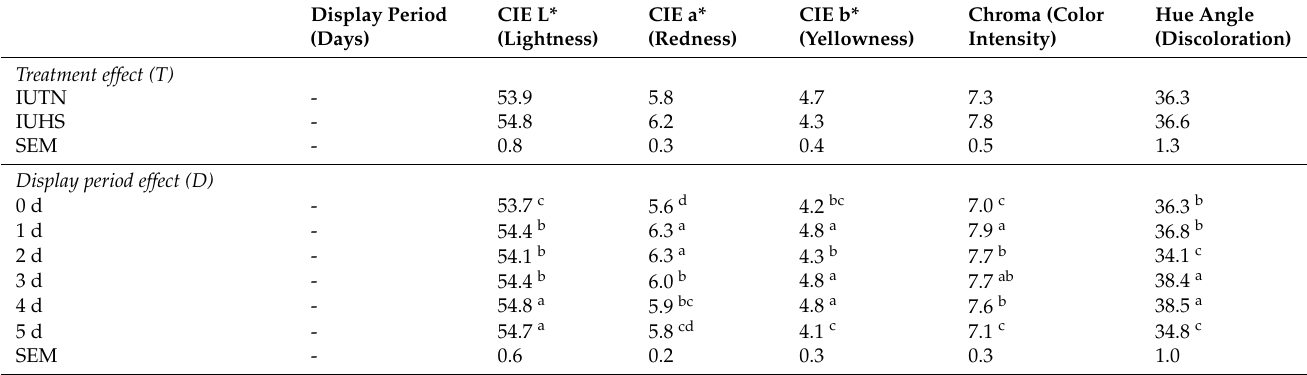
Table 4. Main and interactive effects of IUHS treatment and aerobic display storage on instrumental color attributes of pork loin muscle ( n =